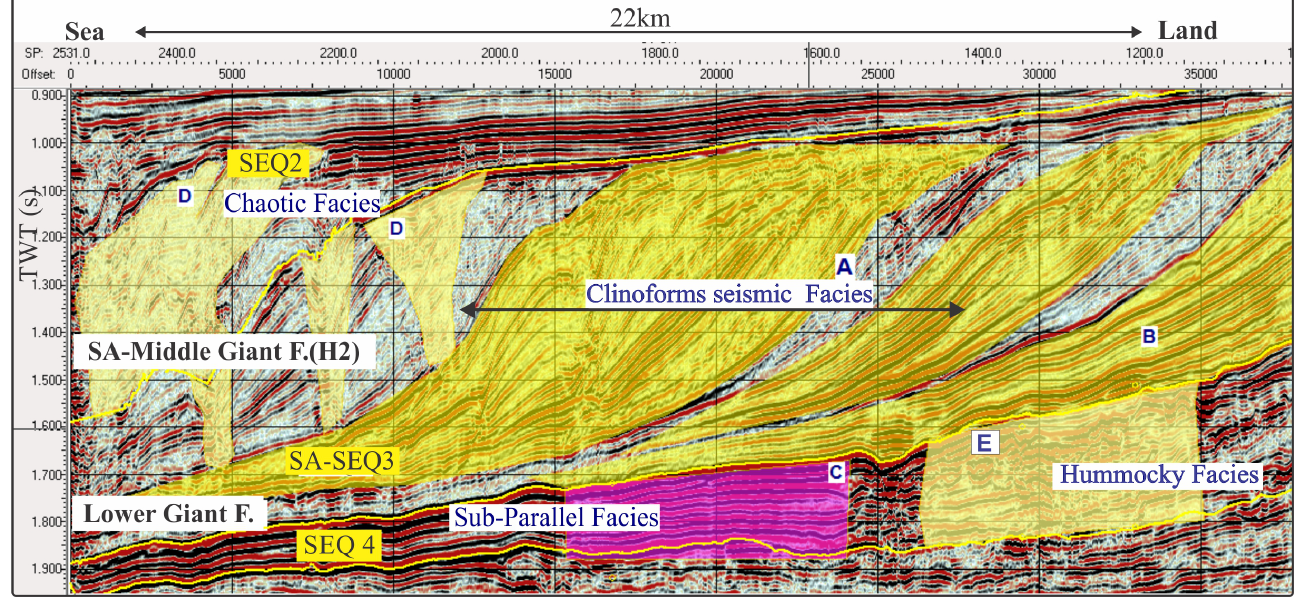
Figure 8. The Middle and Lower Giant Formation